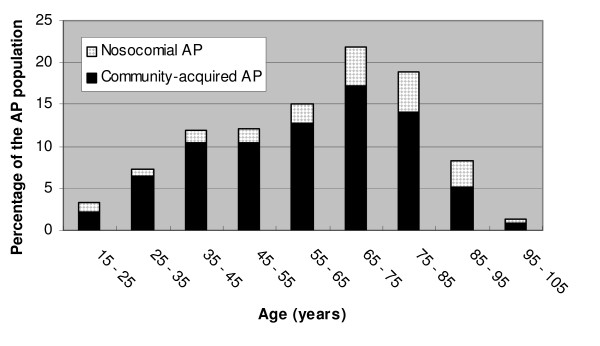
Distribution of 371 patients with acute prostatitis (AP) according to their age and to the mode of contamination.